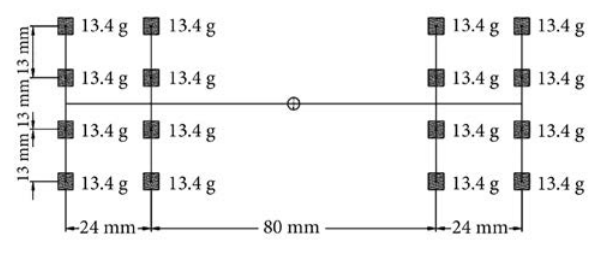
Fig. 7. Loading distribution on wheels applied on the skewed integral bridge model